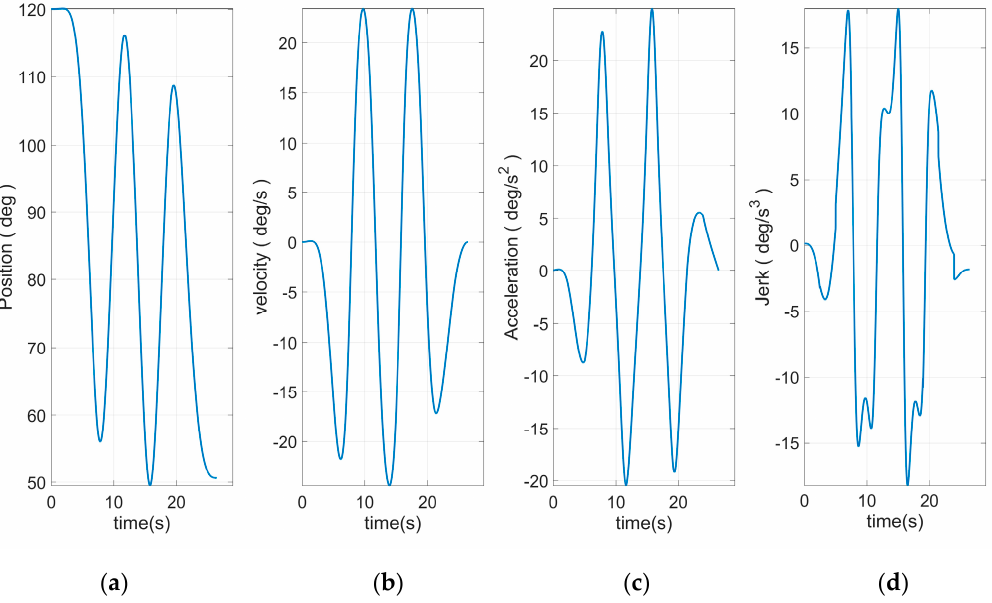
Figure 22. ( a ) Displacement of axis III over time by using seven segments S-curve. ( b ) Velocity of axis